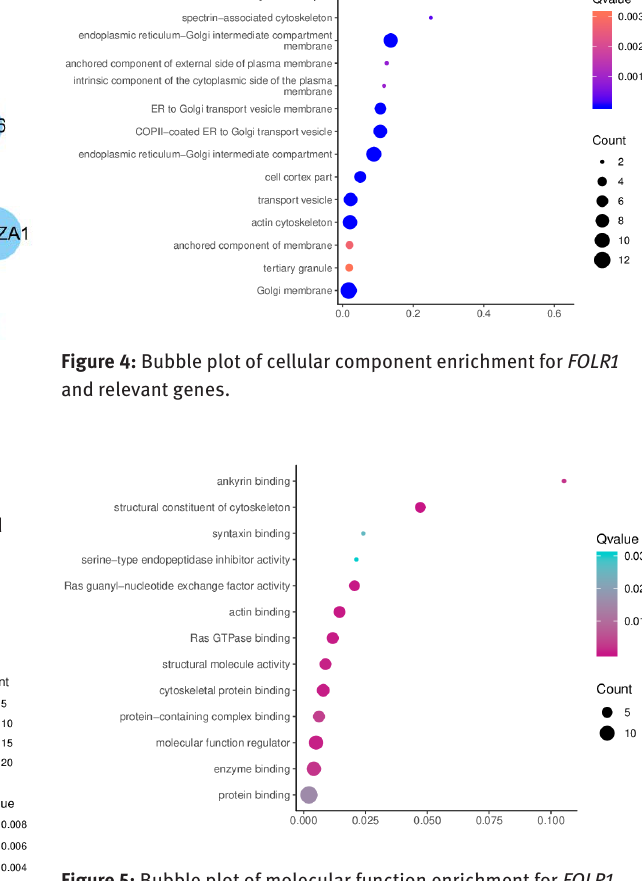
Figure 5: Bubble plot of molecular function enrichment for FOLR1 and relevant